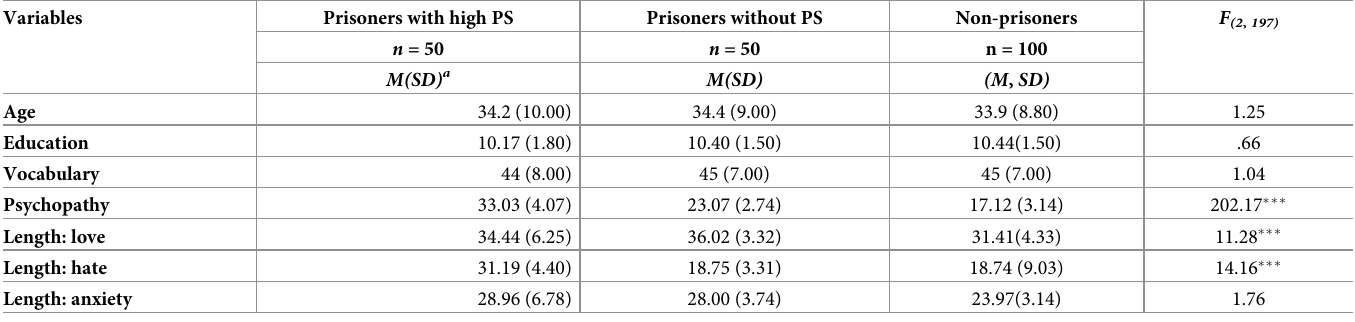
Table 1. Comparisons between the groups (demographic, intellectual characteristics, length of narratives): Prisoners with high psychopathy scores, prisoners with low psychopathy scores, non-prisoners with low psychopathy scores ( n = 200). Variables Prisoners with high